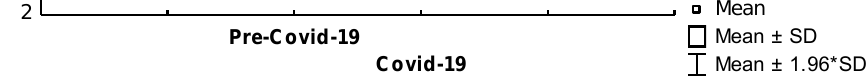
Figure 2. A comparison of the number of daily steps in the analyzed periods ( p < 0.001).